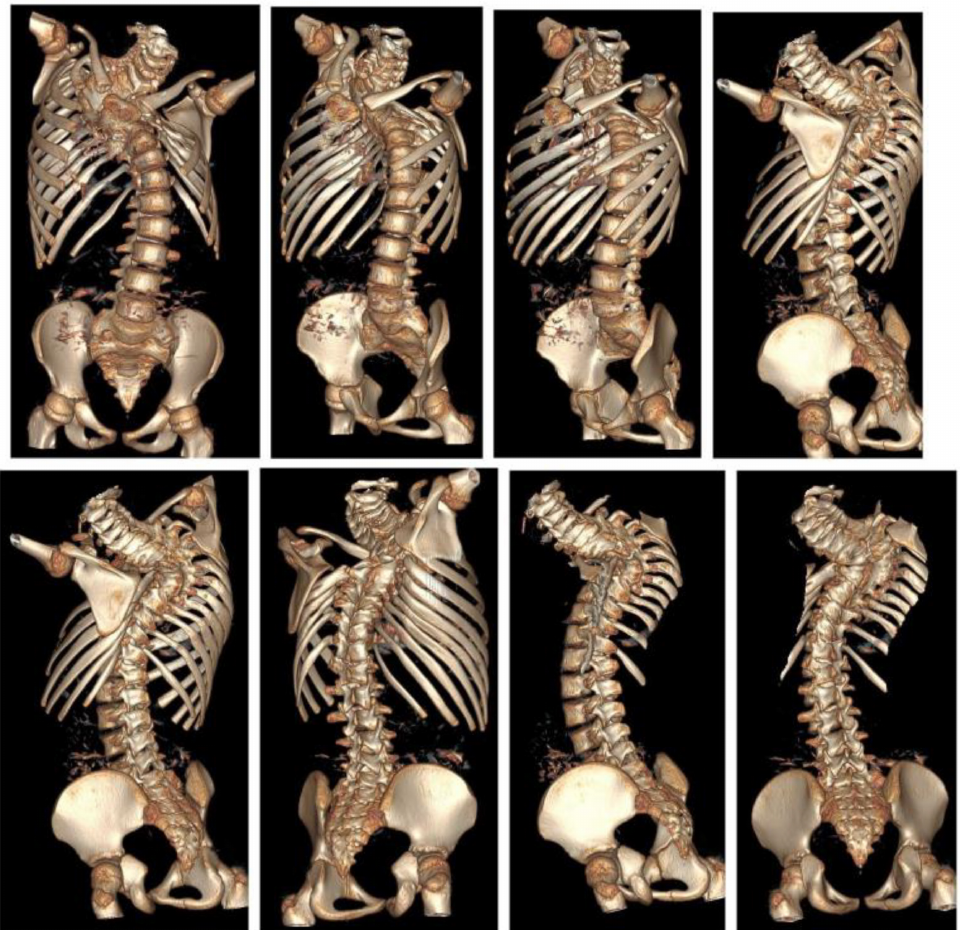
Figure 2. 3D computed tomography of the five-year-old girl before surgical treatment. Angio-CT examination of blood vessels in the neck, chest, and abdomen showed no pathological structure. The patient underwent posterior vertebral column resection of T3–T4 (the blocked vertebrae) using the costotransversectomy approach (Figures 4 and 5) with posterior pedicle screw stabilization and fusion between C7 and T9. Correction of the deformity included right-sided compression and left-sided dis- traction. The pleura remained intact during the surgery, and no chest tube was needed (Figure